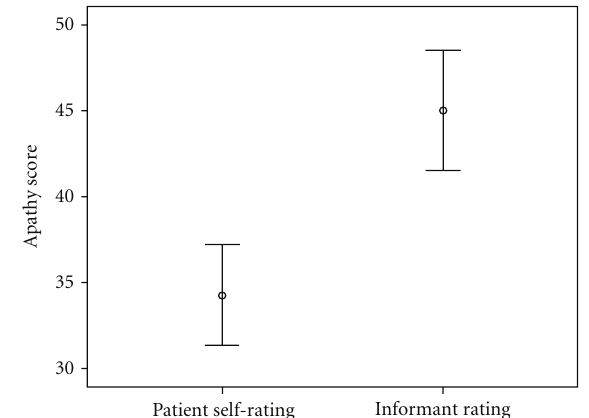
Figure 2: Distribution of self- and informant-rated levels of apathy.